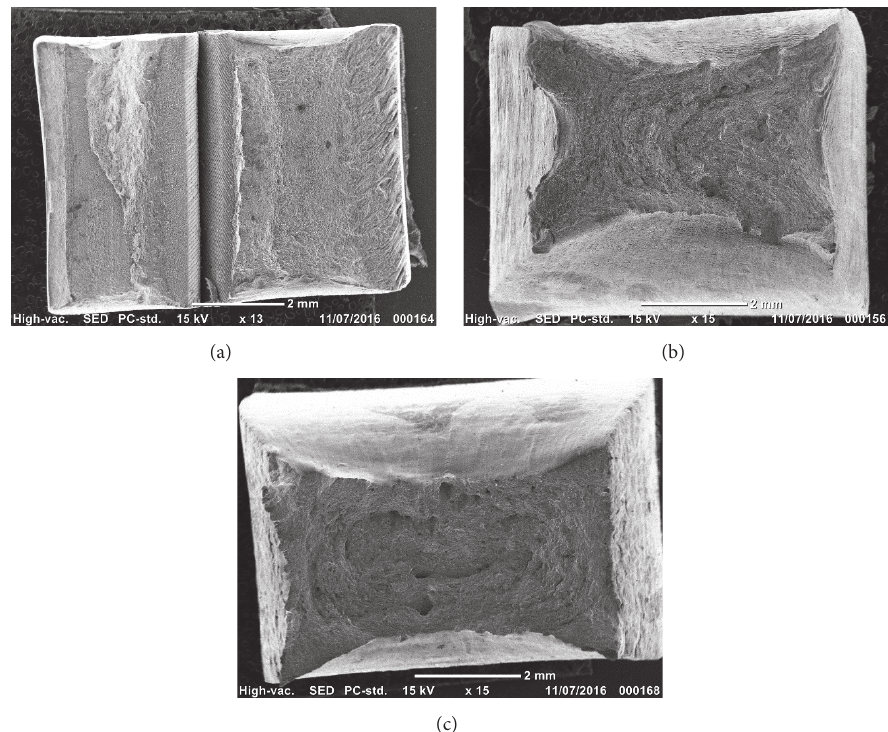
Figure 10: Fracture surfaces for tensile specimens: (a) with tunnel defect, (b) without tunnel defect, and (c) for the base material.